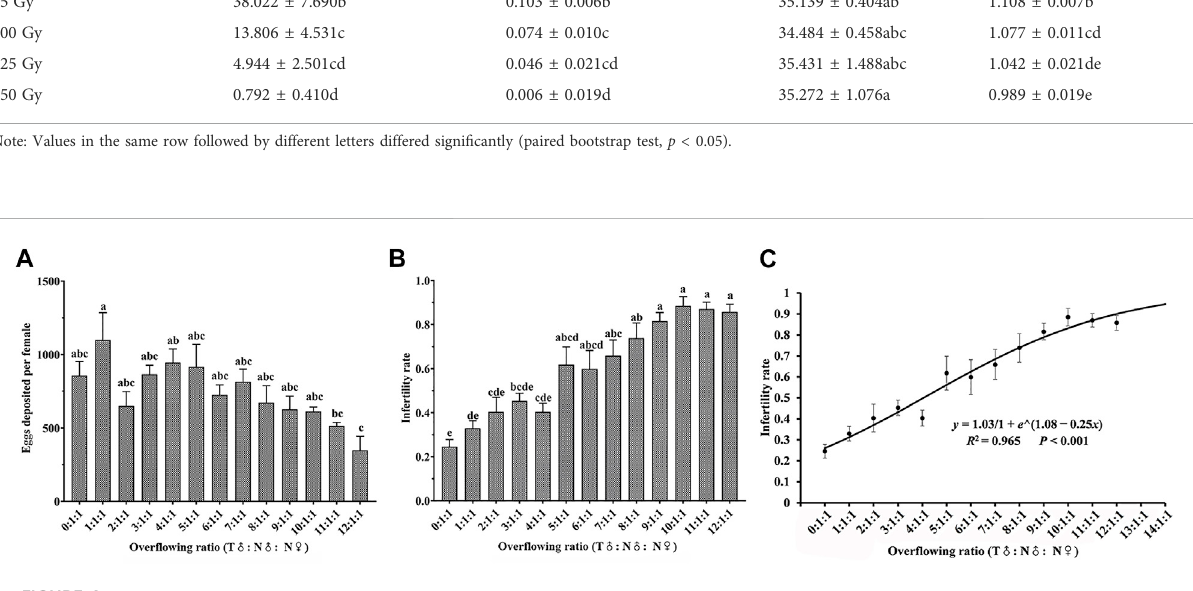
FIGURE 4 Effects of different release ratios of substerilized males (irradiated with 75 Gy dose of X-rays) and nonirradiated males on fecundity (A) , sterility rate (B) and logistic curve of sterility rate of Spodoptera litura (C) . Data are means ± SE; signi fi cant differences (one-way ANOVA, Tukey ’ s HSD; p < 0.05) among doses for a variable are shown by different lowercase